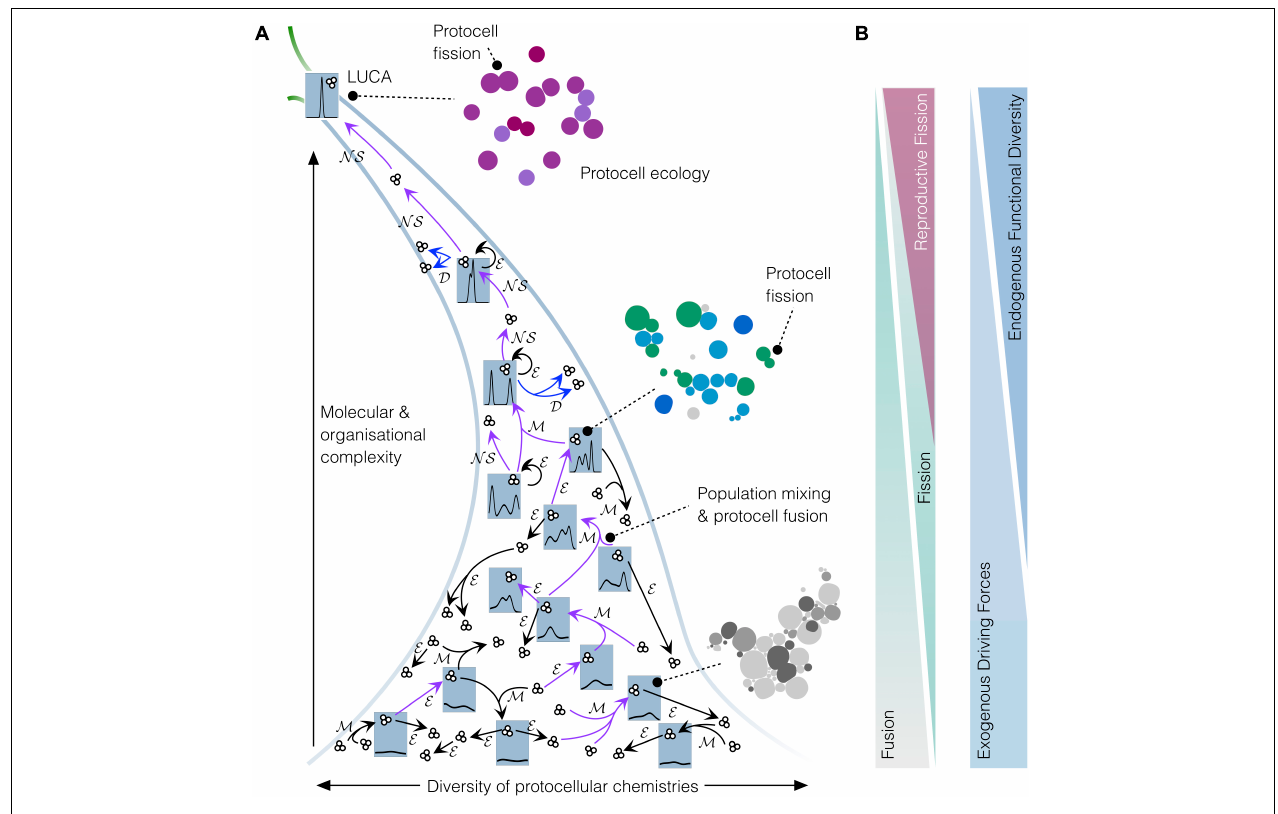
FIGURE 2 | Coarse-grain analysis of the emergence of protocell types in populations of interacting protocells, on their journey toward LUCA. (A) Narrowing funnel depicts an early, ‘messy’ prebiotic chemistry with a large diversity of colloidal aggregates (individuals and groups of individuals of low molecular and organizational complexity) developing toward relatively more homogenous sets of higher-complexity individuals. Small clusters of three circles represent protocell sets/populations and blue tabs depict the probability density of protocell types or “families” within the whole set at each stage. At the early ‘messy’ stage, the global system did not contain identifiable types of protocells; however, mixing events M would have caused recombination and fusion of individuals, sometimes resulting in individuals of higher complexity. Diverse chemistries, mixing processes, along with environmental influences M would eventually lead to the emergence of the first functional protocells (purple arrows depict key transitions toward higher complexity). Once functional diversity increased sufficiently, these protocells developed the capacity to autonomously grow and reproduce ( D , blue arrows), starting to generate protocell types and to evolve through natural selection ( NS ), thus constituting primitive ‘lineages’ and proper ‘populations.’ (B) The diminishing role of environmental driving forces and protocell fusion, and conversely the increasing role of protocell fission (and, thereby, NS ) and functional diversification, in driving transitions toward higher complexity on the road between messy colloidal chemistry and